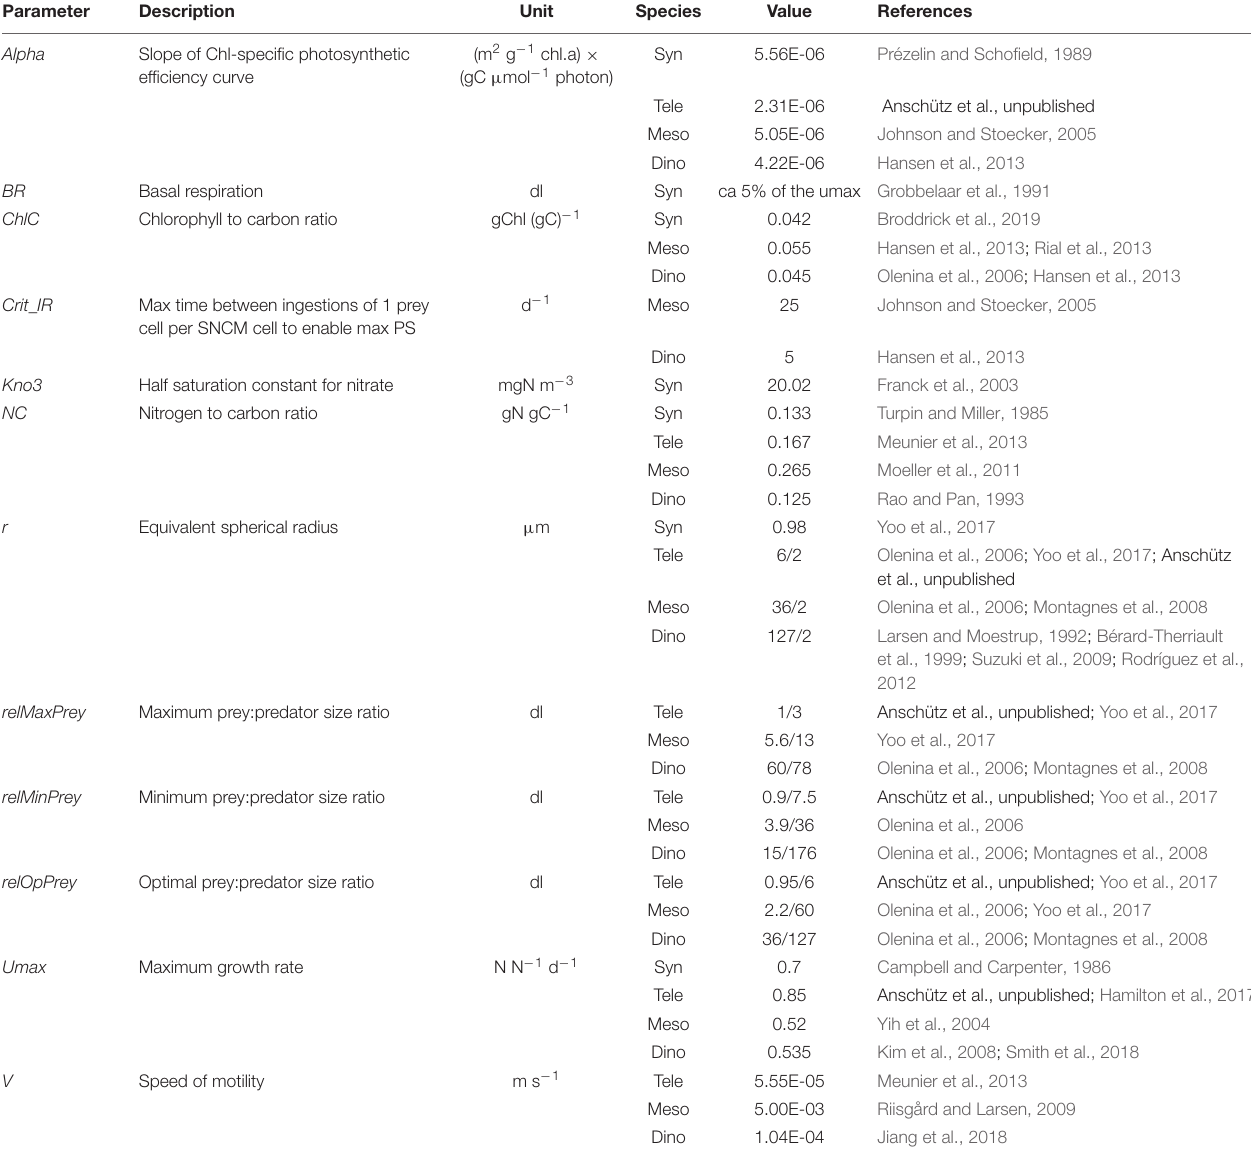
TABLE 2 | Values of constants used to configure the Synechococcus (Syn), Teleaulax (Tele), Mesodinium (Meso), and Dinophysis (Dino) submodels.